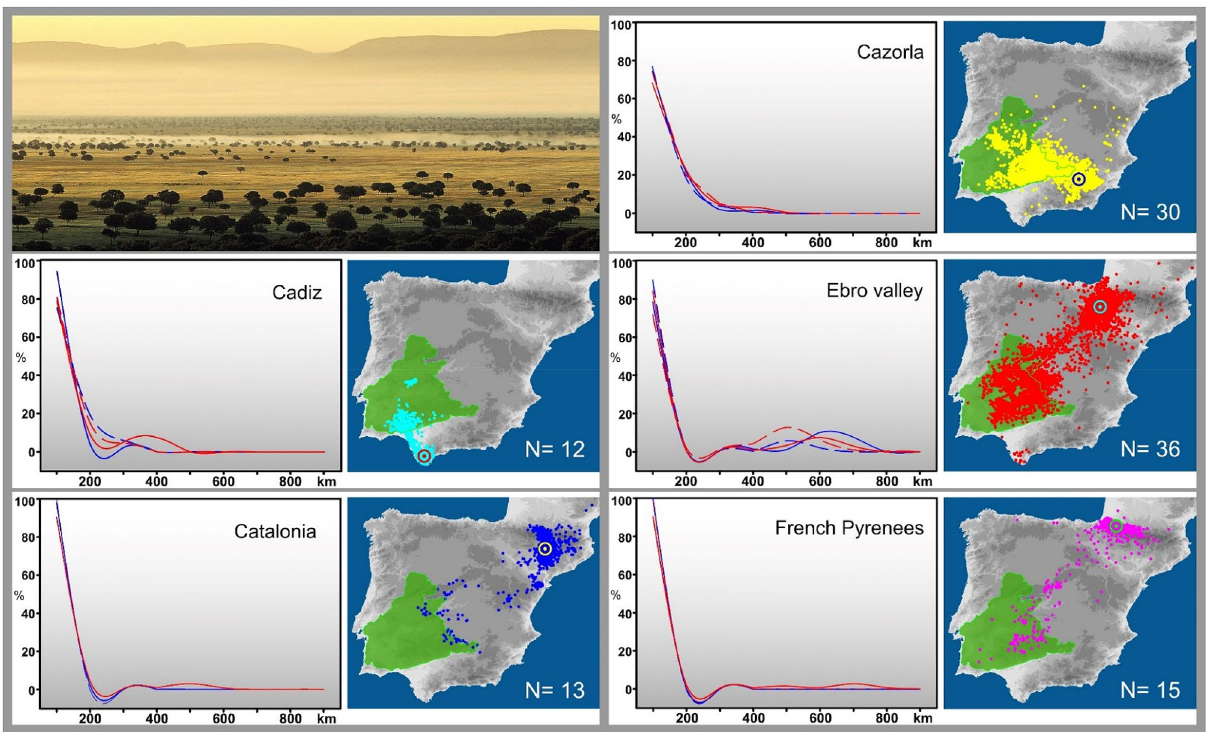
Figure 1. Study populations and areas. Above left: “dehesa” landscape in central Iberia (Cabañeros National park) (Photo: V. García-Canseco). We show a panel for each study population with both a map of the daily locations and the splined distribution of their distances to the nest or activity center. Continuous and discontinuous lines represent males and females respectively (Winter in blue, summer in red). The mean position of nests/activity centers for each population is shown by a circle. The distribution of the “dehesas” in the Iberian Peninsula is shown in green (depicted from CORINE land Cover). Maps were generated using QGIS